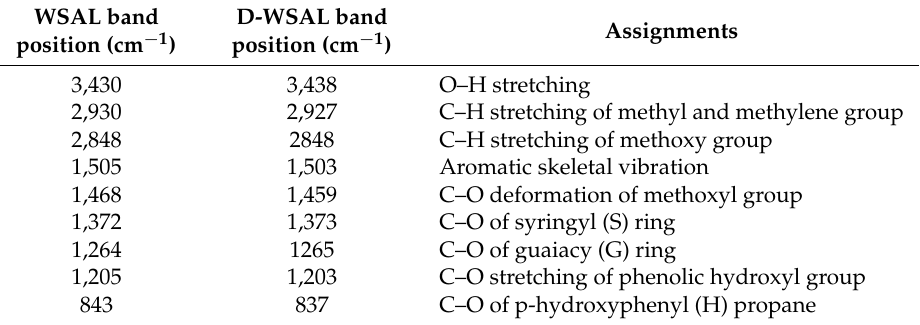
Table 5. Assignments of characteristic absorption peaks from the FTIR spectra of WSAL and D-WSAL.